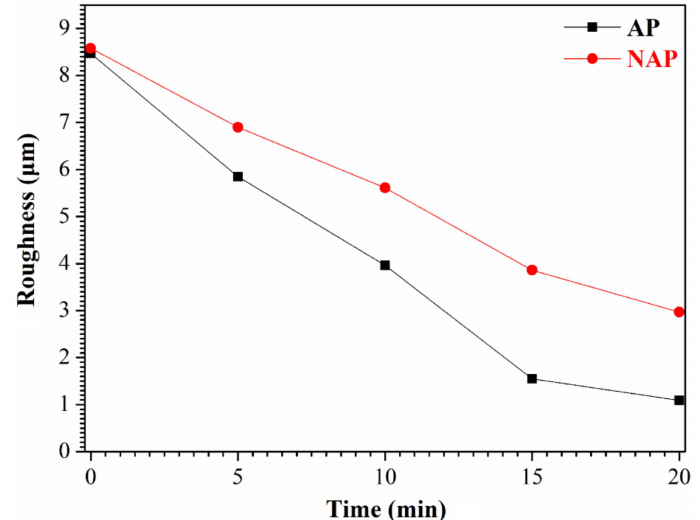
Figure 7. The roughness–time curves of the NAP and AP samples for durations of 5 min, 10 min, 15 min and 20 min.